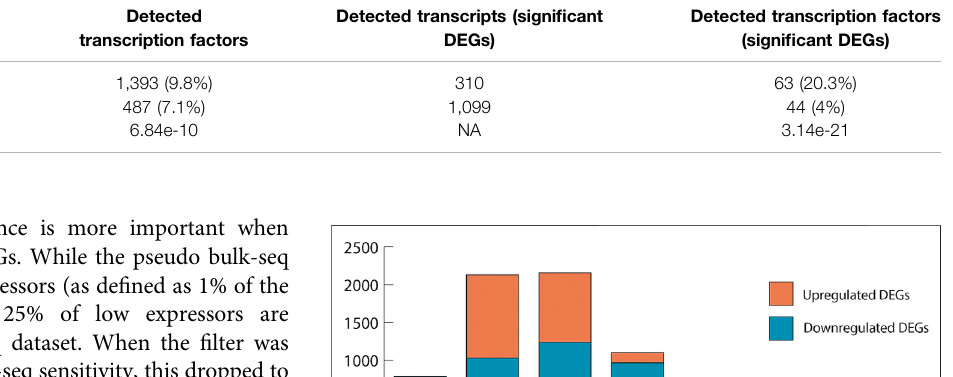
TABLE 5| Detectionoftranscription factorsisreducedinpseudobulk-seq.TBxCB:TCDD bulk-seqvscontrolbulk-seq. TPxCP:TCDD pseudobulk-seqvscontrolpseudo bulk-seq. Cells pertaining to signi fi cant DEGs are shaded. Chi-squared test. Detected transcripts